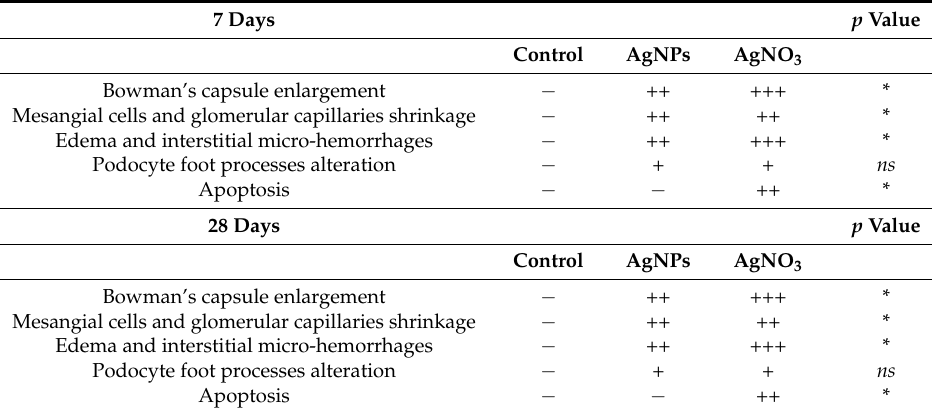
Table 1. Semi-quantitative scoring of renal lesions in control and treated rats. 7 Days p Value Control AgNPs AgNO 3 Bowman’s capsule enlargement − ++ +++ * Mesangial cells and glomerular capillaries shrinkage